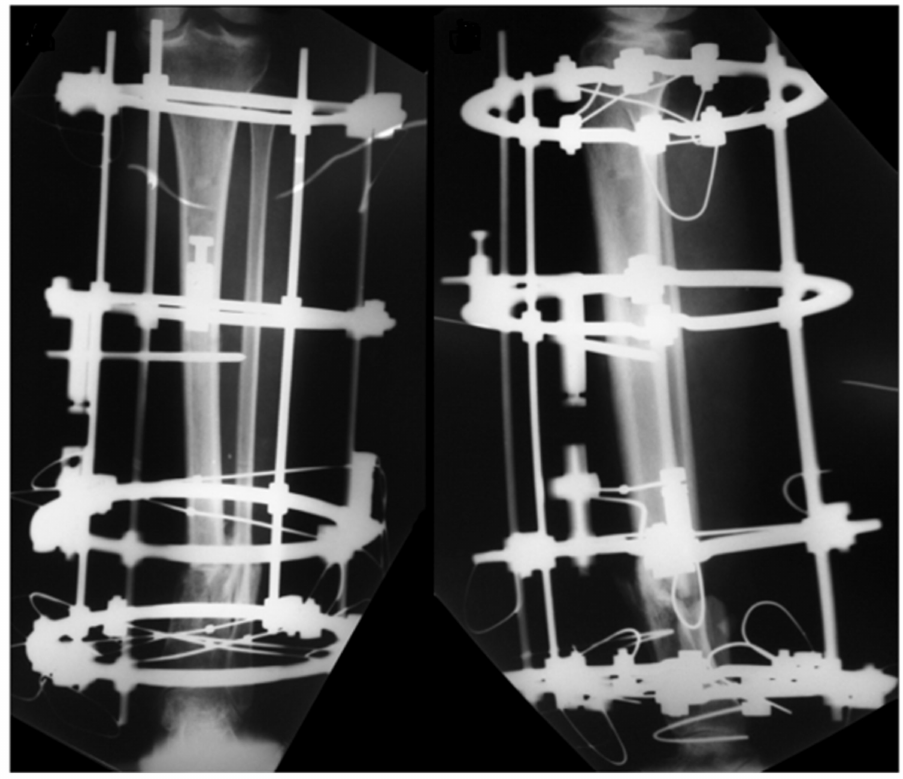
Figure 6. AP and lateral radiographic views of the left leg demonstrating the adequate alignment of the fracture and slight progression of bone healing, with minimum varus on the fracture